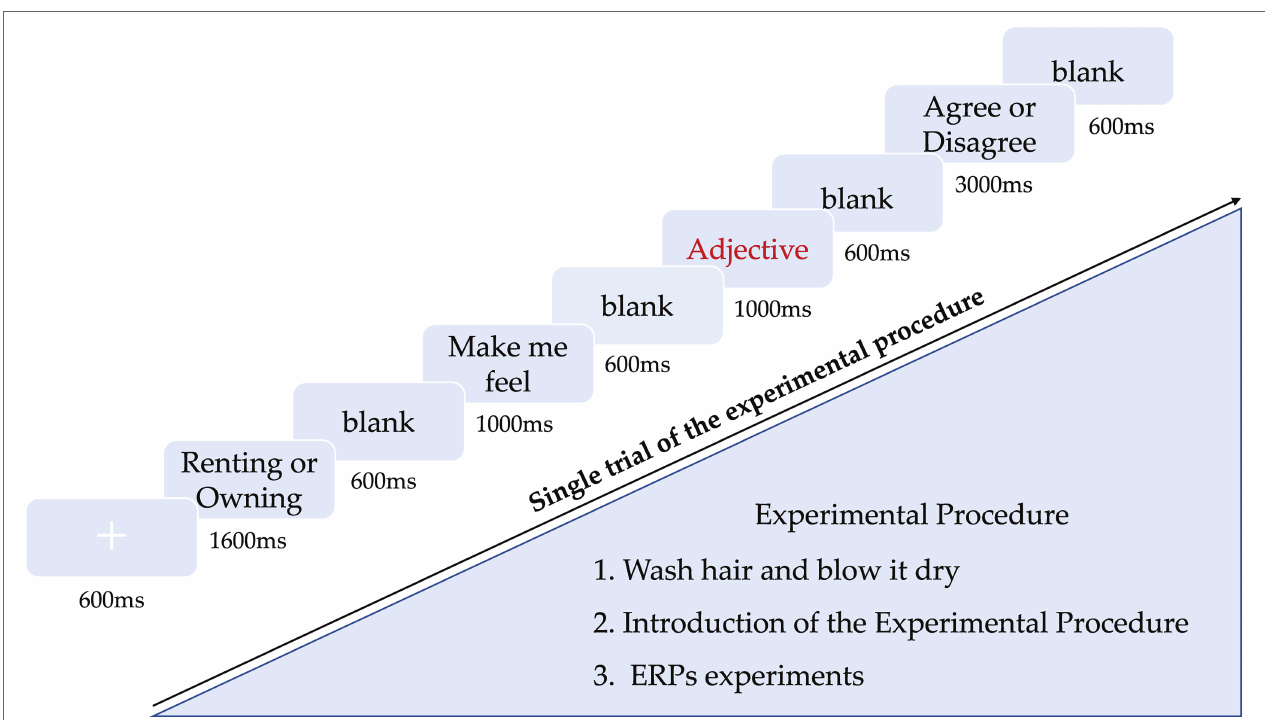
FIGURE 2 | Single trial of the experimental